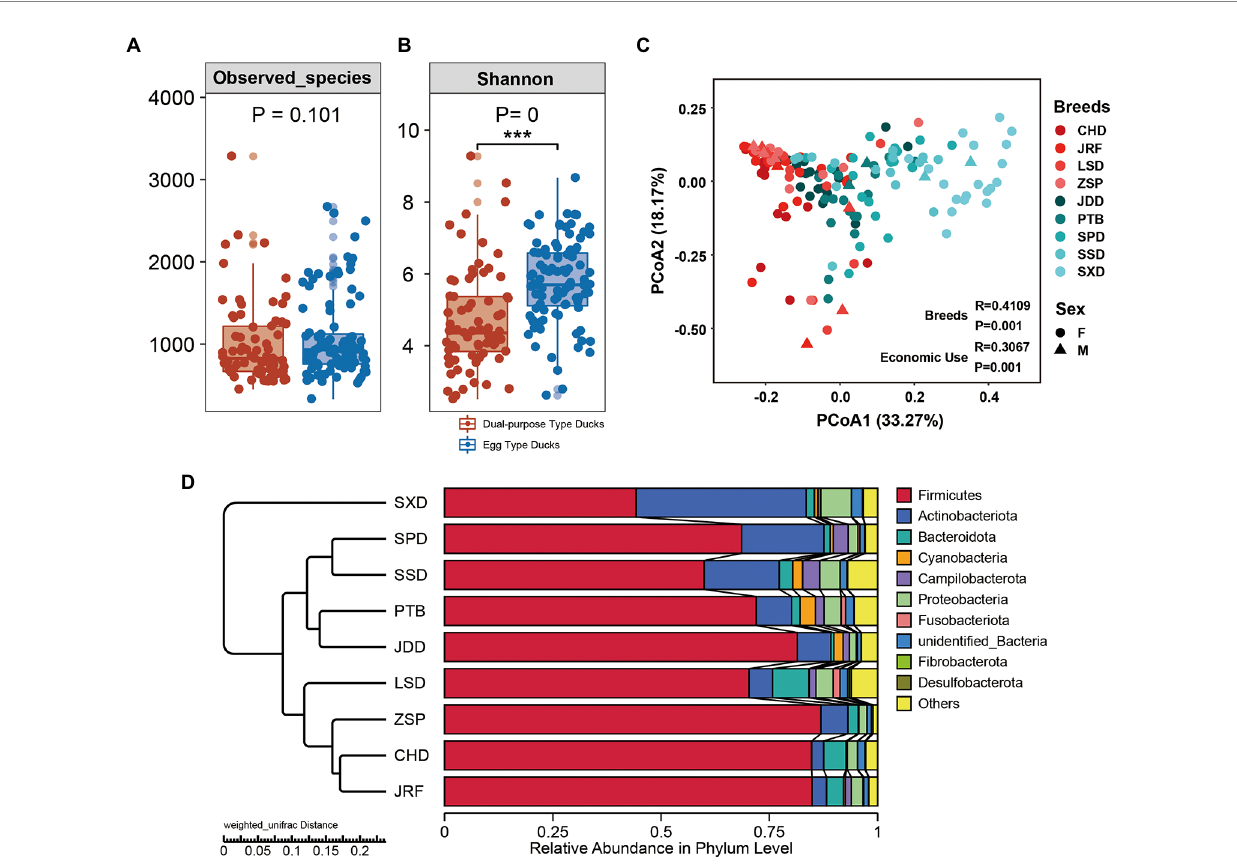
FIGURE 3 Alpha diversity and microbial community structures across dual-purpose and egg type ducks. (A) The observed richness and (B) Shannon diversity index of microbial communities in samples from domestic ducks. Principal Co-ordinates Analysis (PCoA) on Weighted Unifrac distances among sample types was plotted based on OTU abundances in (C) domestic duck samples. (D) Microbial community bar plot with cluster tree of the nine Chinese duck breeds.